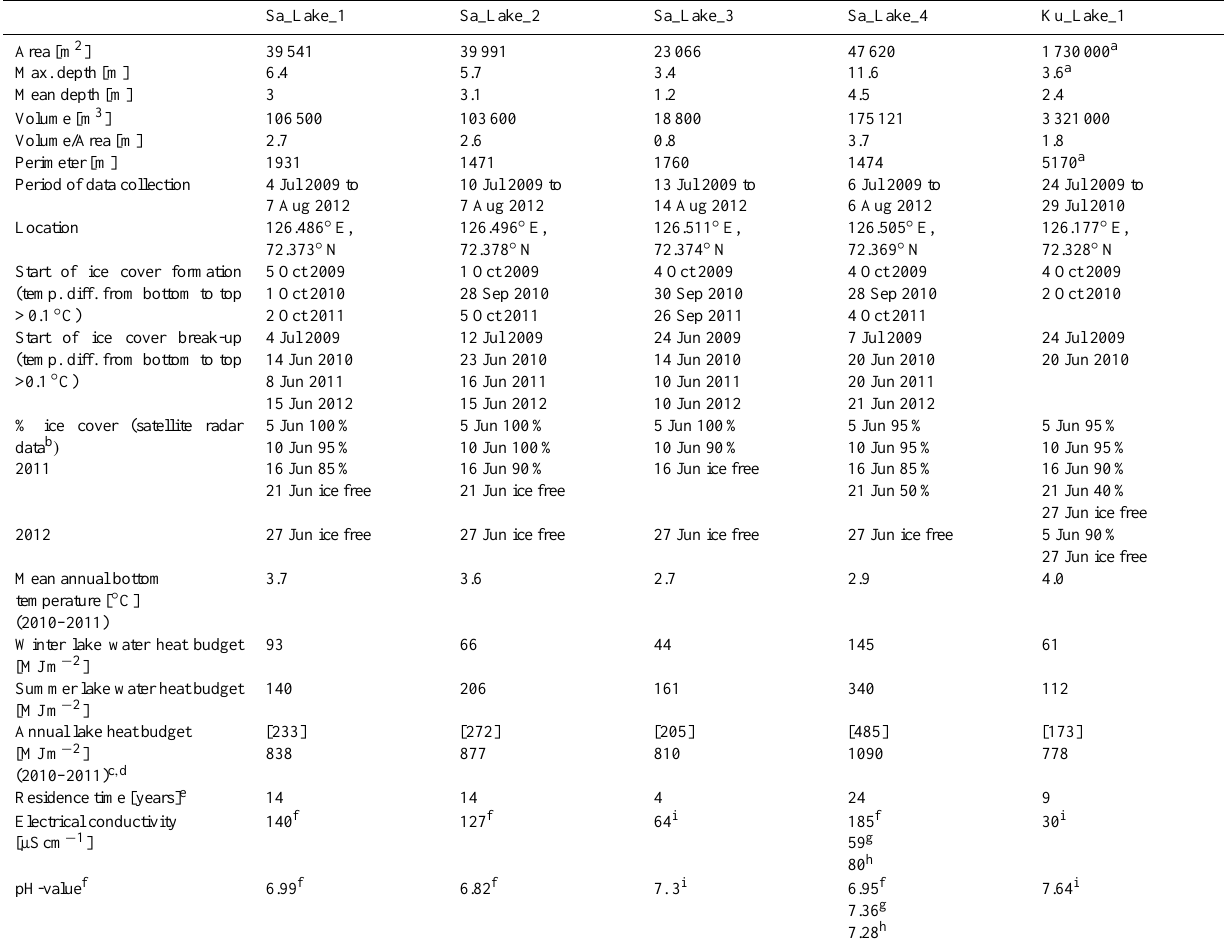
Table 1. Physical and chemical characteristics of the studied lakes in the Lena River Delta,